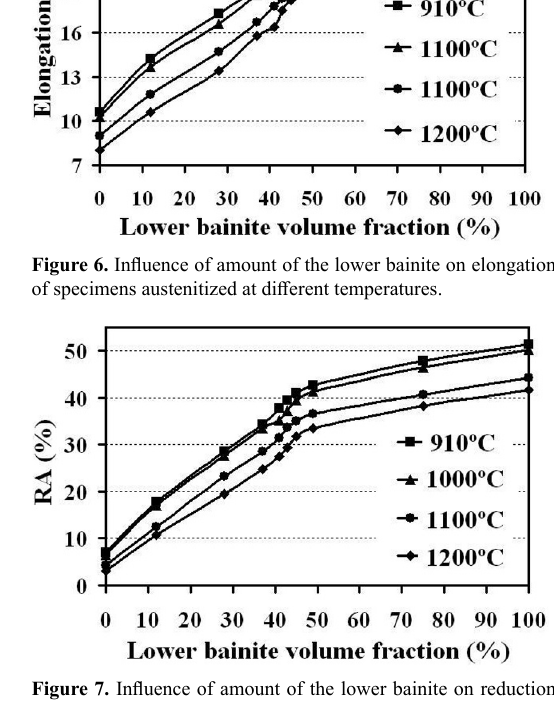
Figure 7. Influence of amount of the lower bainite on reduction area of specimens austenitized at different temperatures.